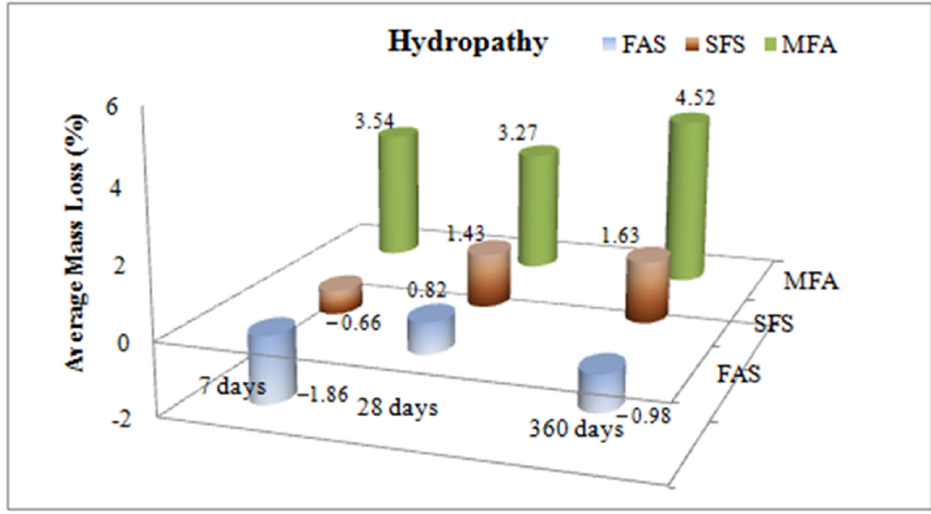
Figure 8. Effects of mineral admixtures on mass loss in hydropathy.